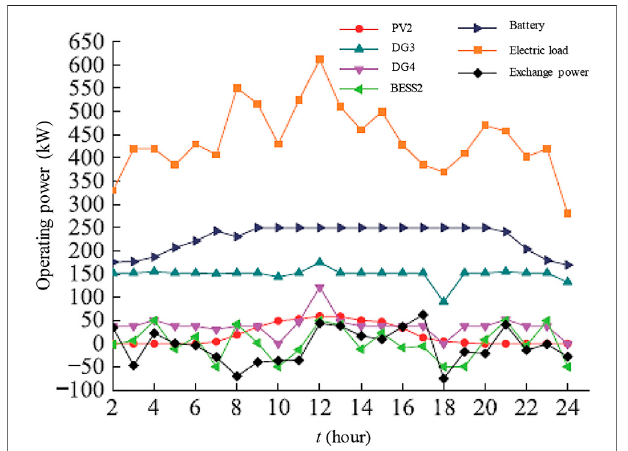
FIGURE 12 | Comparison of power optimization of the third region.